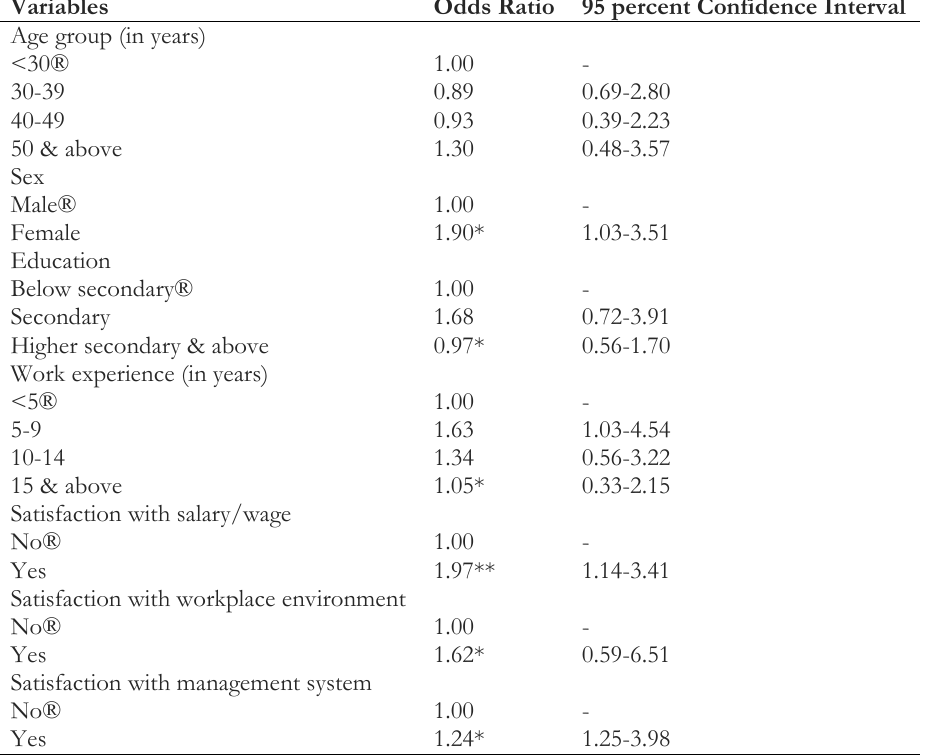
Table 3. Determinants of job